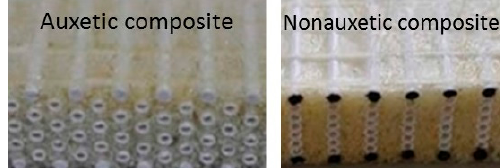
Figure 5. Studied composites by Jiang et al. Adapted from [20].